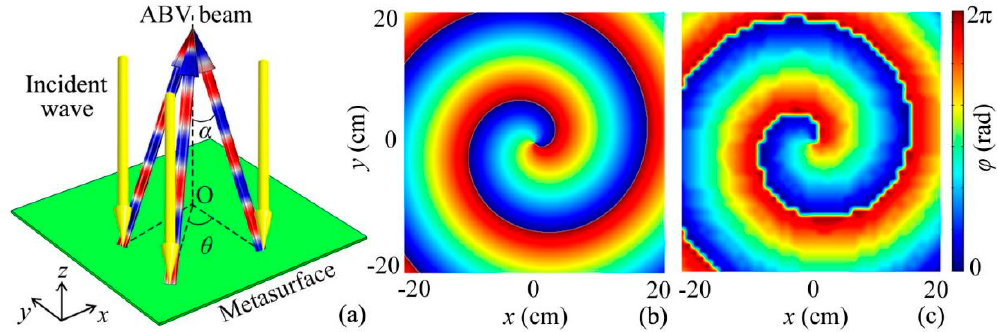
Figure 2. Design of the reflected ABV beam. ( a ) Schematic of a quasi-3D reflected metasurface of ABV beam, and its ( b ) theoretical continuous and ( c ) discrete phase profiles.